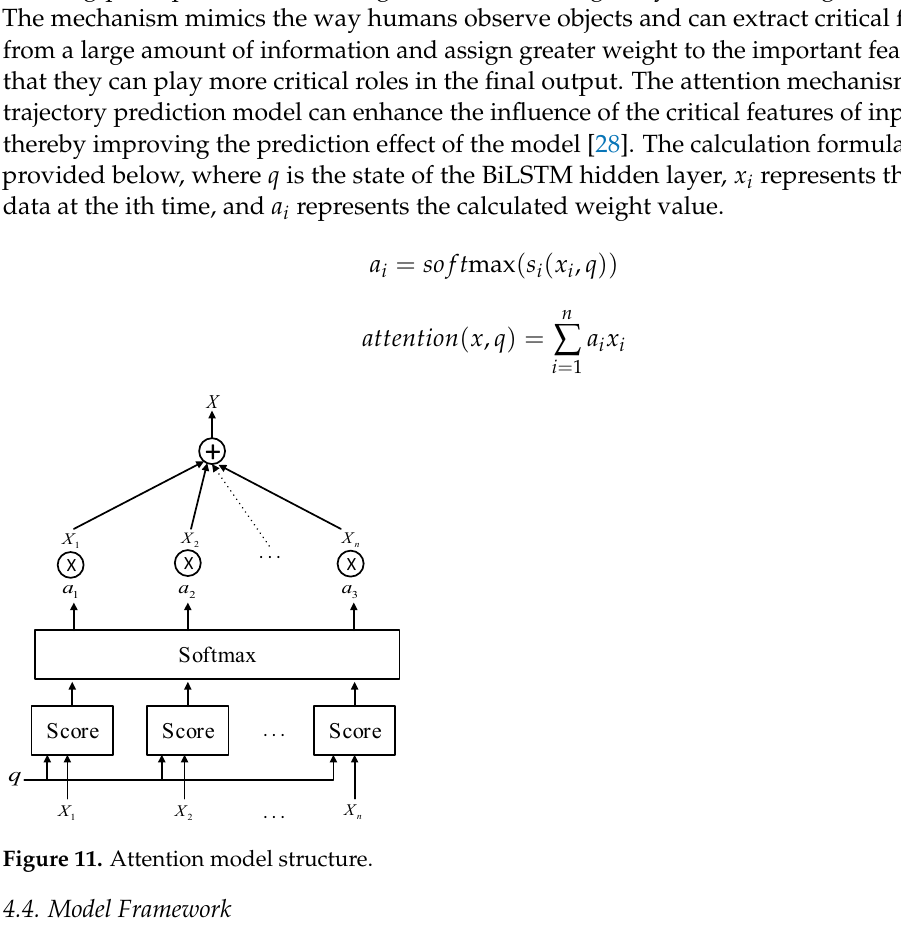
Figure 12. Model framework. 5. Experiment and Analysis